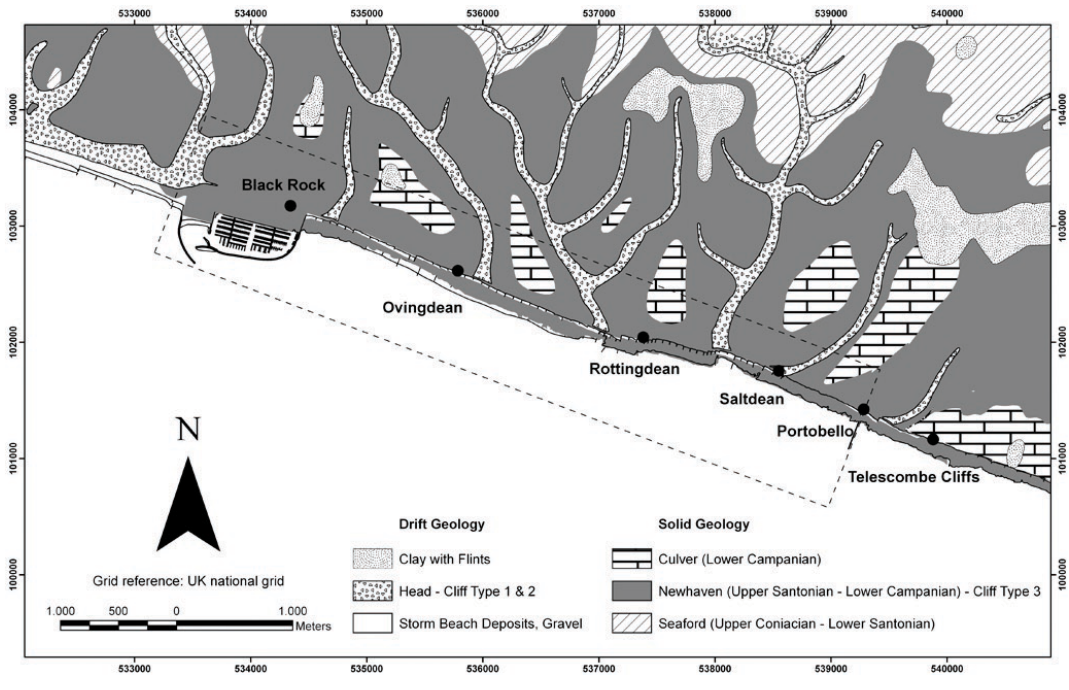
Fig. 3. Distribution of the solid and drift geology along the site.